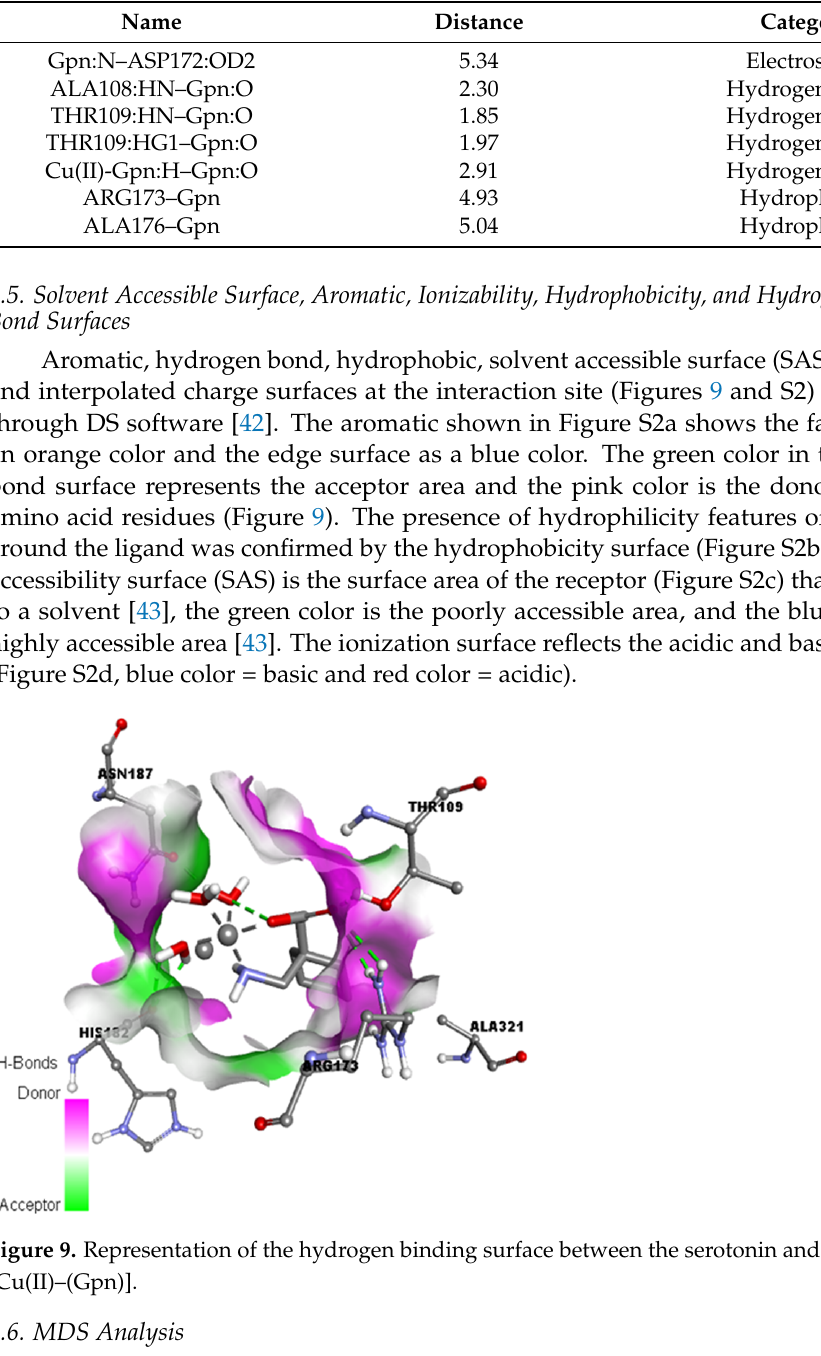
Figure 10. The root mean square deviation (RMSD) of the solvated receptor backbone and ligand complex during the 100 ns MD simulation [unbound serotonin receptor (yellow), GpnS complex (black), and CuGS complex (brown)]. According to the literature, a RMSD value under <3.0 Å is the most acceptable [44]. The drop in the RMSD value for CuGS showed an alteration in the secondary structure conformation of the protein due to the [Cu(II)–(Gpn)] interaction. This finding shows that CuGS developed a more stable combination. The results confirm that this interaction brings protein chains closer and reduces the gap between them, as shown in Figure 11 [45]. Figure 11. The superimposed structure of ( a ) the unbound serotonin receptor (yellow) and serotonin receptor after simulation (brown) for GpnS and ( b ) the unbound serotonin receptor (yellow) and serotonin receptor after simulation (green) for CuGS .